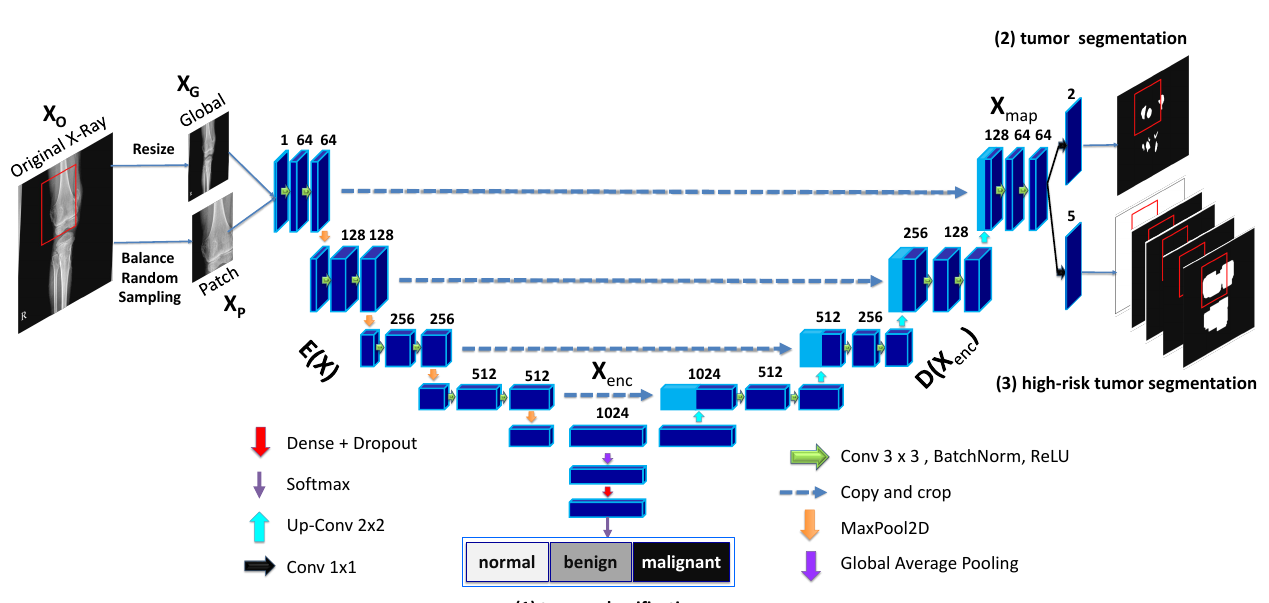
Figure 7. Multi-level Seg-Unet model with global and patch-based